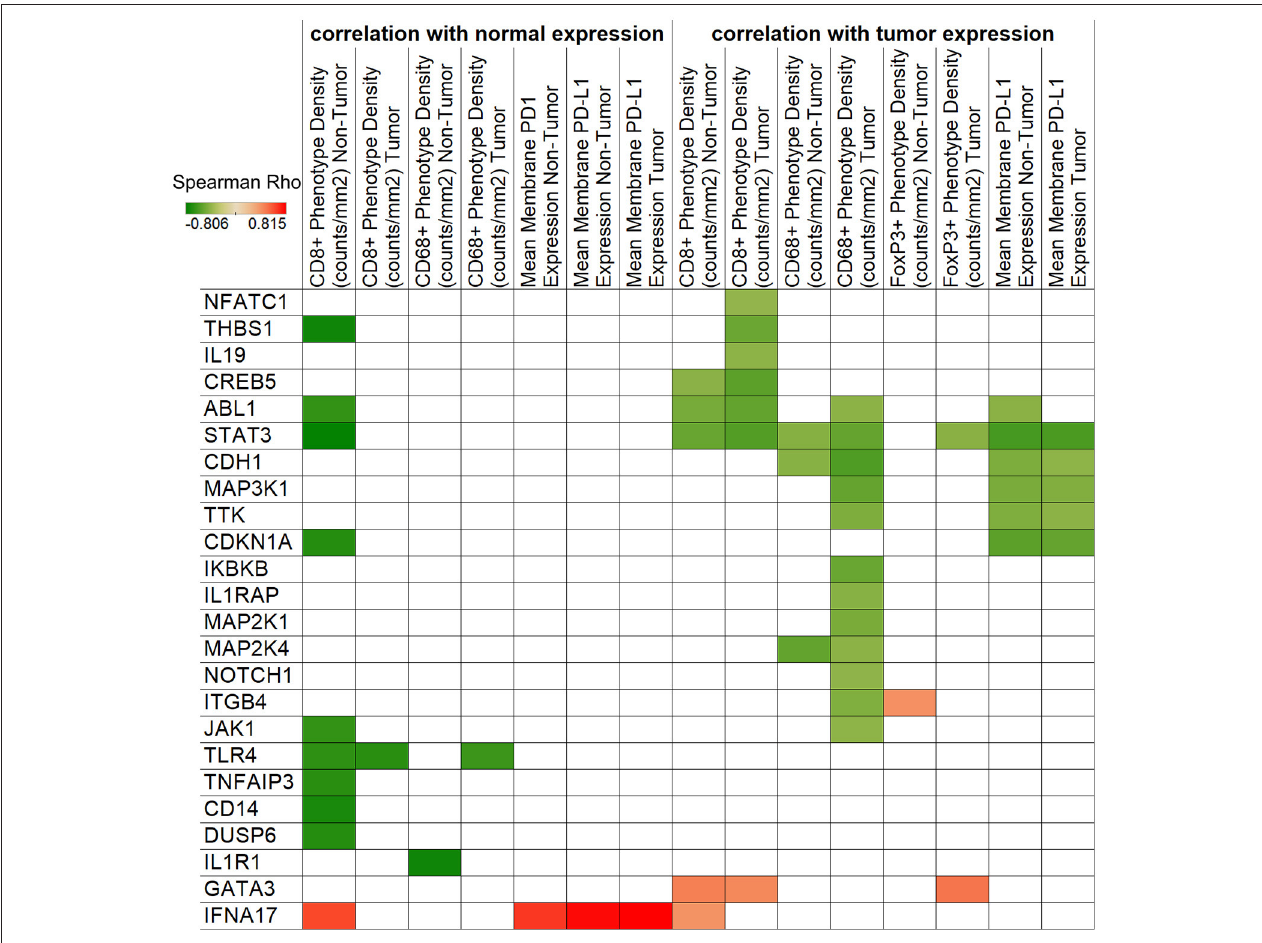
FIGURE 4 | Correlation of IHC and NanoString expressions. Spearman’s rank correlation coefficients are represented by color for NanoString genes and IHC densities/expressions. The left side of the figure shows correlations with normal tissue gene expression, while the right side displays tumor expression associations. Only significant ( p < 0.05) correlations are